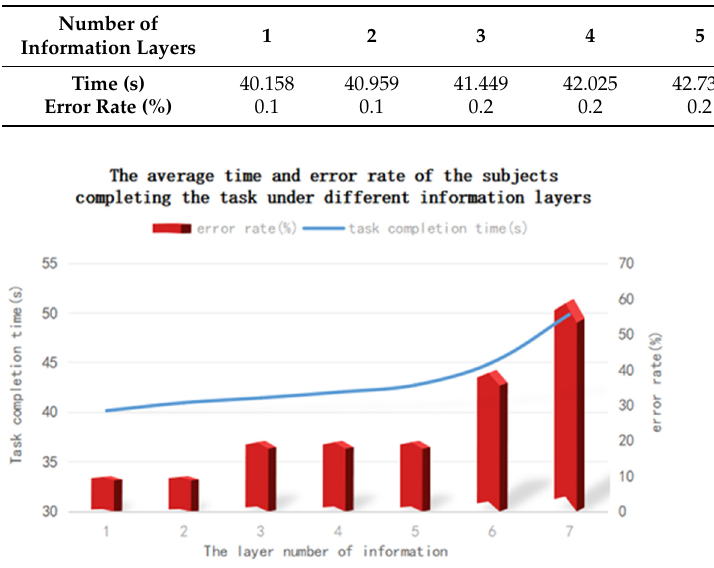
Table 11. The average time and error rates of the subjects to complete the task under different numbers of information layers.